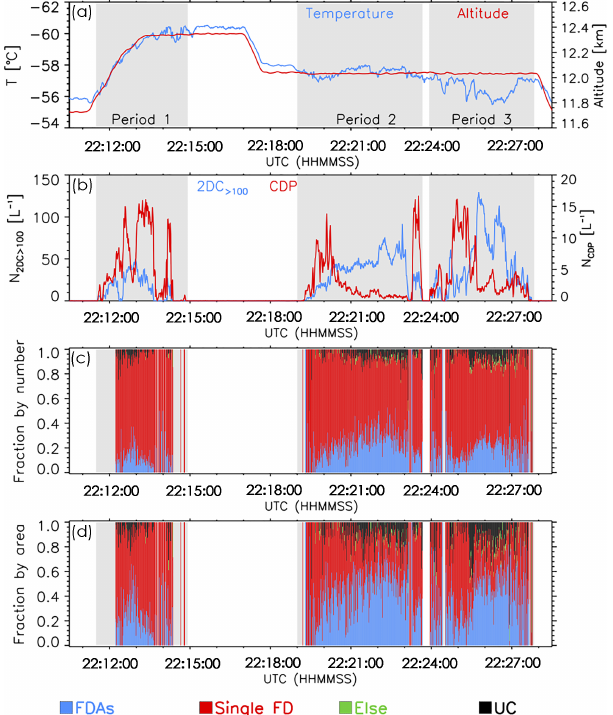
Figure 2. (a) Temperature and altitude of the NSF/NCAR GV air- craft as a function of time on the 6 June 2012 flight and (b) the 1s average concentration of measured CDP and 2DC > 100 . De- termined habit fraction (c) by number and (d) by projected area as a function of time. Habit categories for panels (c) and (d) are shown using the colored legend under the figure . Habits are sorted into 15 categories: frozen droplet aggregates (FDAs), small quasi- sphere (SQS), medium quasi-sphere (MQS), large-quasi sphere (LQS), plate, aggregates of plates, bullet rosette, aggregates of bul- let rosettes, column, aggregates of column, needle, aggregates of needles, dendrite, capped column, and unclassified as shown in Fig. 2. For simplicity single frozen drops (FD) denoted in this figure includes SQS, MQS, and LQS, while other habits except FDAs and UC are indicated as “Else” in this figure. Time periods 1, 2, and 3 are shaded gray in each panel.